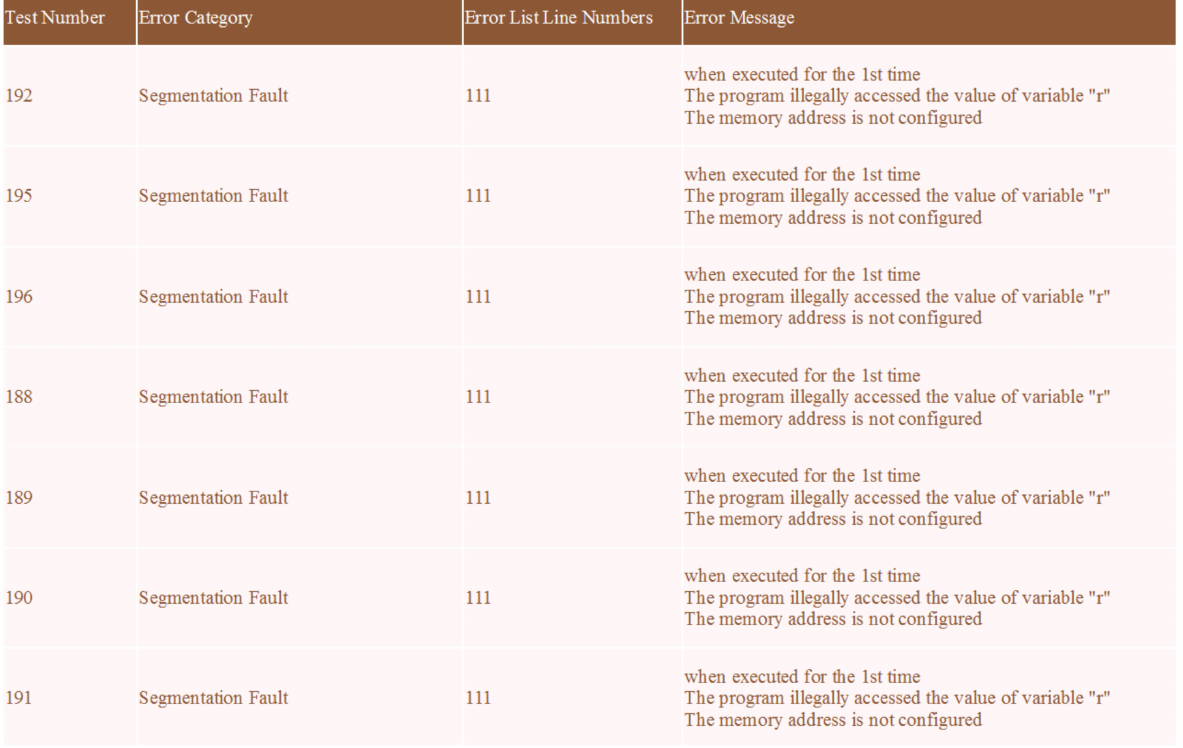
Figure 25. Feedback report